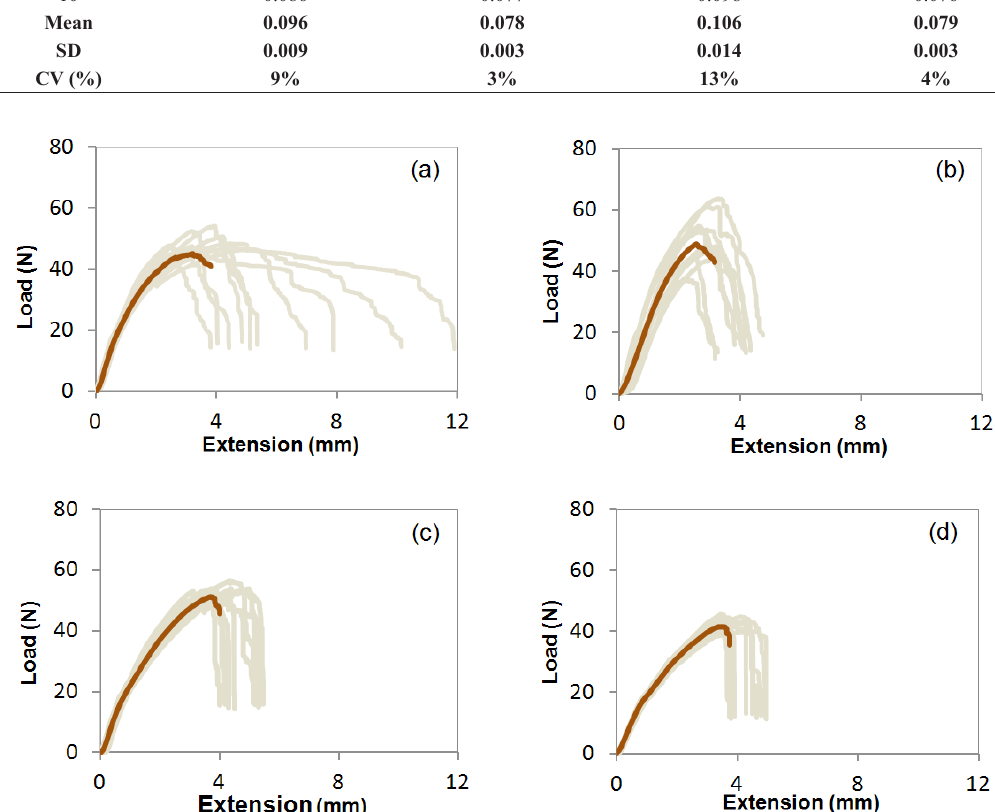
Figure 5- Average load-extension curve: macrofibre A (normal conditions) a); macrofibre A (mixed conditions) b); macrofibre B (normal conditions) c); macrofibre B (mixed conditions)